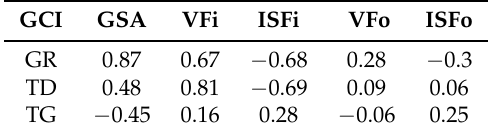
Table 11. Pearson’s correlation between impact factors and GCI indicators of